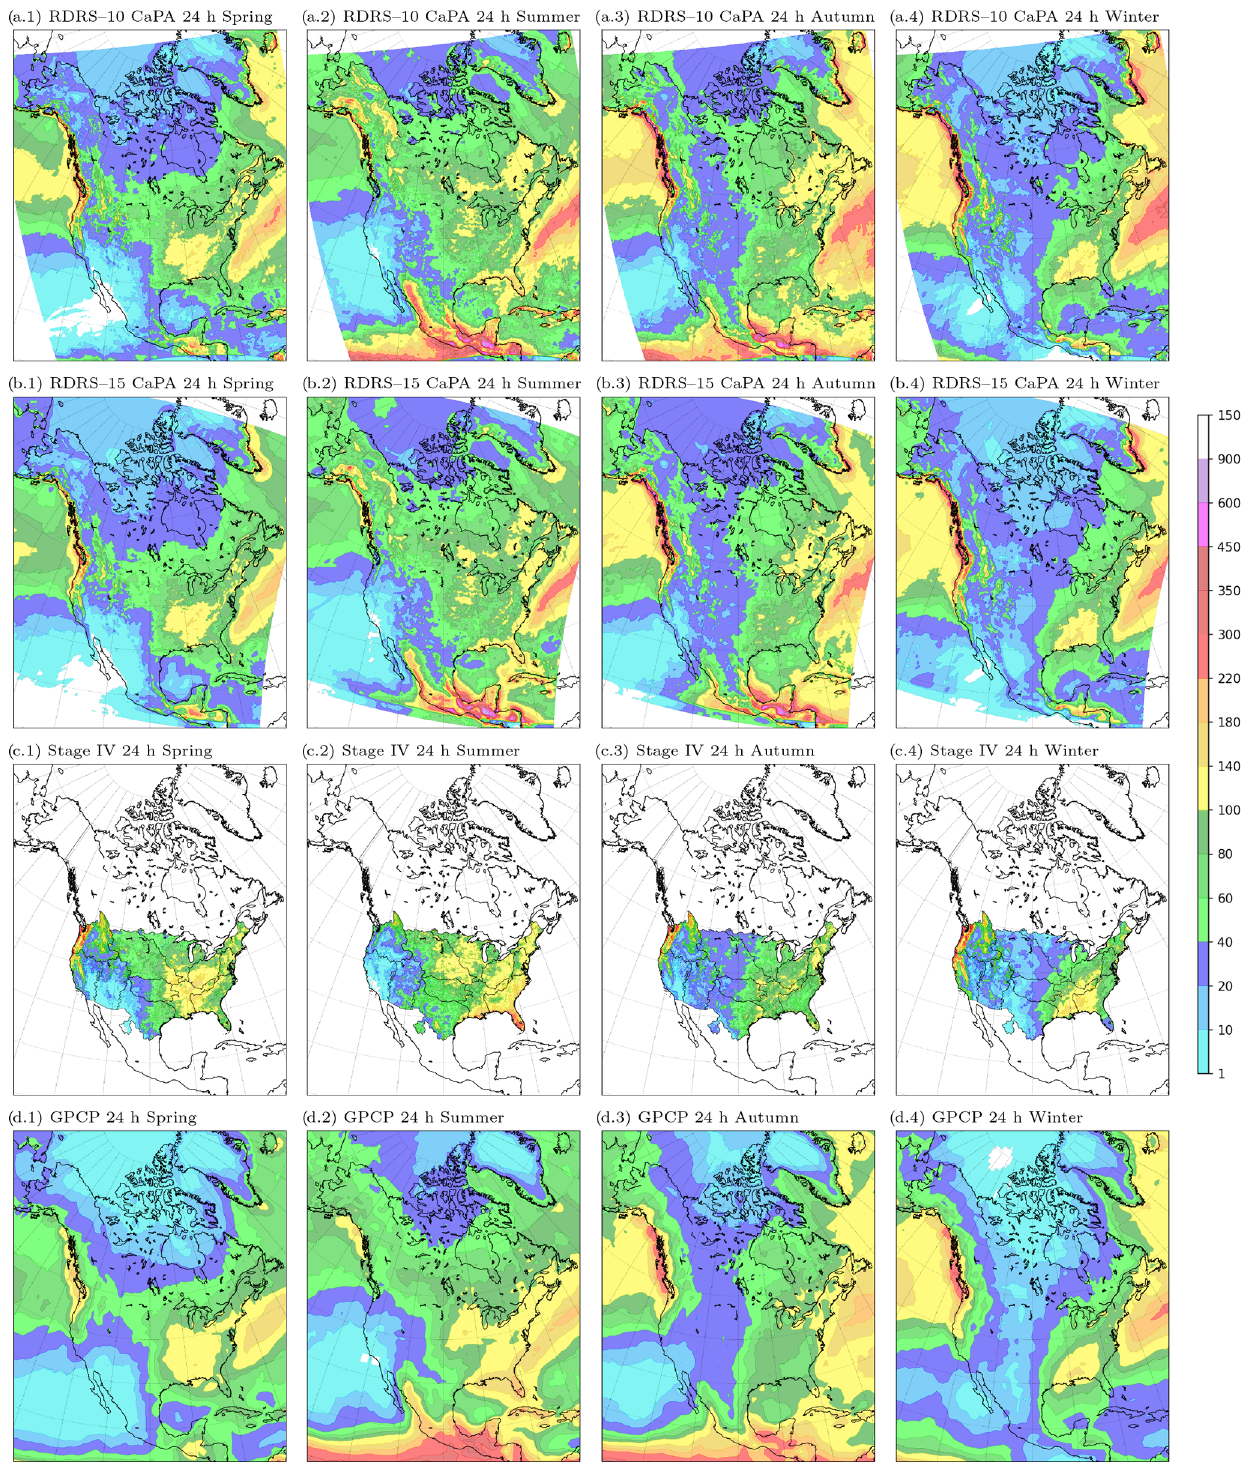
Figure 8. Precipitation accumulation per seasons [mm/month] over years 2010–2014 for (a) CaPA-24h based on RDRS-10; (b) CaPA-24h based on RDRS-15; (c) NOAA Multisensor Precipitation Estimates (Stage IV) 24h analysis; and (d) Global Precipitation Climatology Project (GPCP) monthly